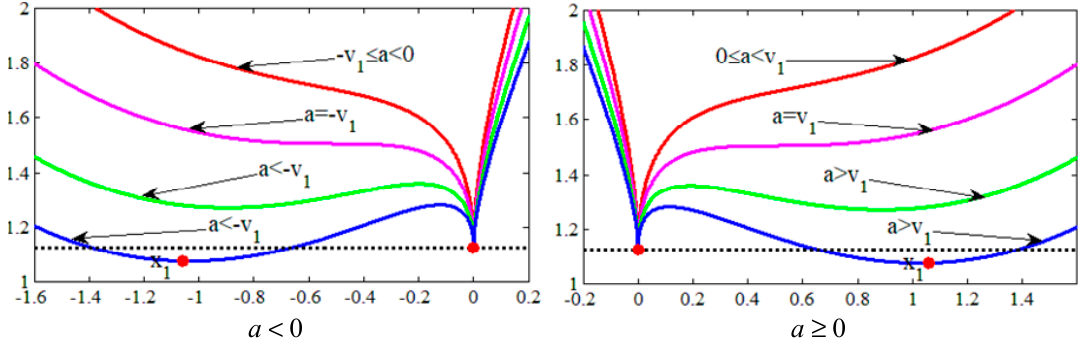
( ) g x curves for different a and λ . Figure 3. Illustration of the g ( x ) curves for different a and λ